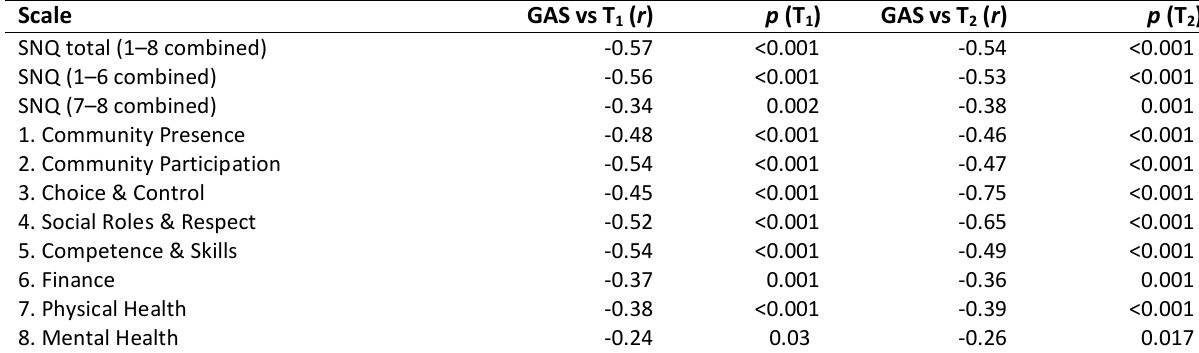
Note: * p < 0.05 ( n = 82). Table 6. Concurrent validity of SNQ total and sub-scales with GAS using Pearson’s “ r ”. Scale